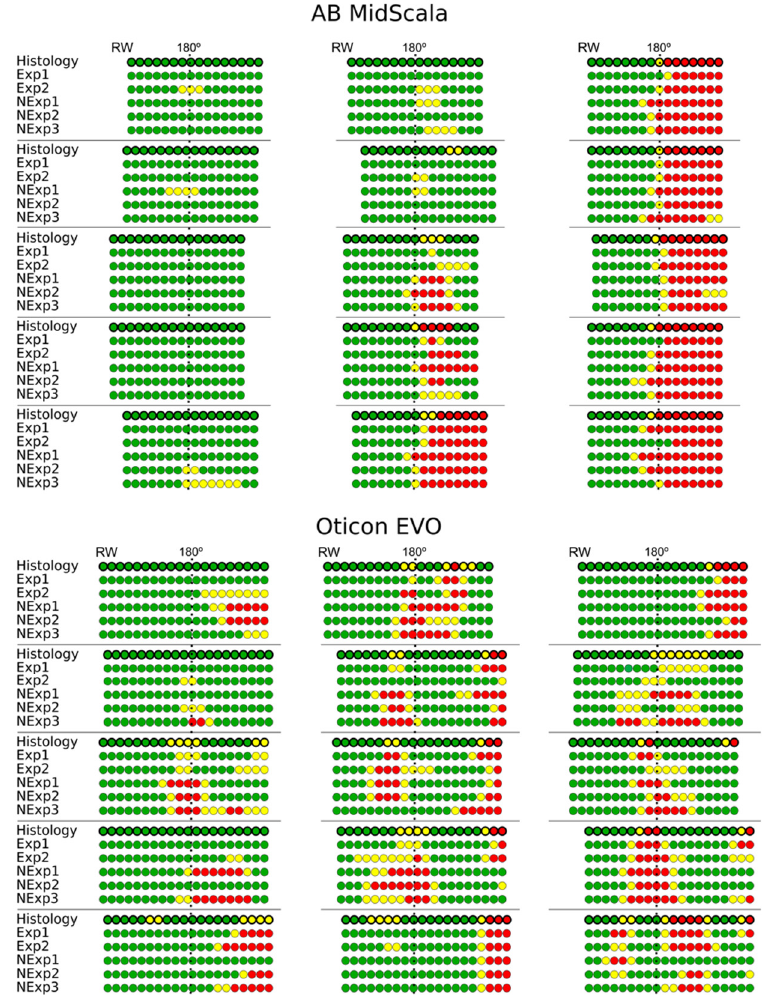
Figure 6. Assessment of the scalar position of the electrodes by five raters according to histology. The electrode array was located according to the positions of the round window (RW) and at 180° (dotted lines). Exp: expert; NExp: non-expert; scala tympani electrode: green circle; intermediate electrode: yellow circle; scala vestibuli electrode: red circle.